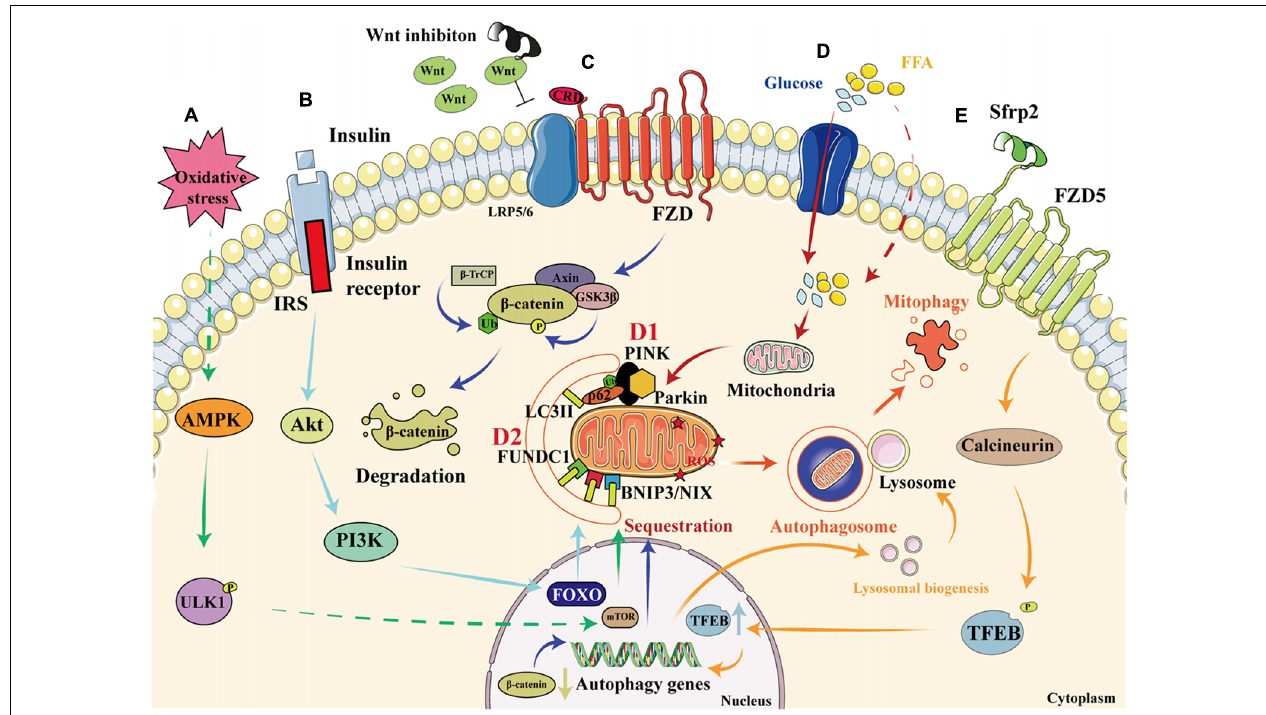
FIGURE 3 | Signaling pathways that regulate mitophagy in diabetic cardiomyopathy. (A) When cardiomyocytes are depleted of energy, mTORC1 dissociates from the ULK1 kinase complex, ULK1 autophosphorylation increases, and this kinase phosphorylates Atg13 and FIP200. In addition, ULK1 is phosphorylated by AMPK, which induces autophagy. (B) When insulin binds to the insulin receptor, an IRS is recruited, which permits the docking of PI3K and the consequent activation of Akt, resulting in greater transcription of FOXO and the upregulation of autophagy. (C) Wnt inhibition prevents its binding to FZD, resulting in the phosphorylation of β -catenin by GSK3 β , which leads to increases in the ubiquitination and degradation of β -catenin, thereby reducing its nuclear translocation and activating autophagy. (D1) High glucose and FFA concentrations cause mitochondrial damage and a reduction in mitochondrial membrane potential. The degradation of PINK is reduced, resulting in the recruitment of parkin to the damaged mitochondria and the ubiquitination of mitochondrial membrane proteins. This process is recognized by P62, which binds to LC3. As a result, the damaged mitochondria are anchored to the autophagic vesicle membrane, which initiates mitophagy. (D2) In addition to the PINK/parkin pathway, the direct binding of FUNDC1 and BNIP3/NIX proteins to LC3 on the mitochondrial membrane also initiates mitophagy. (E) By binding to FZD5, Sfrp2 activates calcineurin to dephosphorylate TFEB. This causes greater nuclear translocation of TFEB, resulting in the transcription of autophagy genes and an increase in lysosomal activity, which promotes the formation and degradation of the